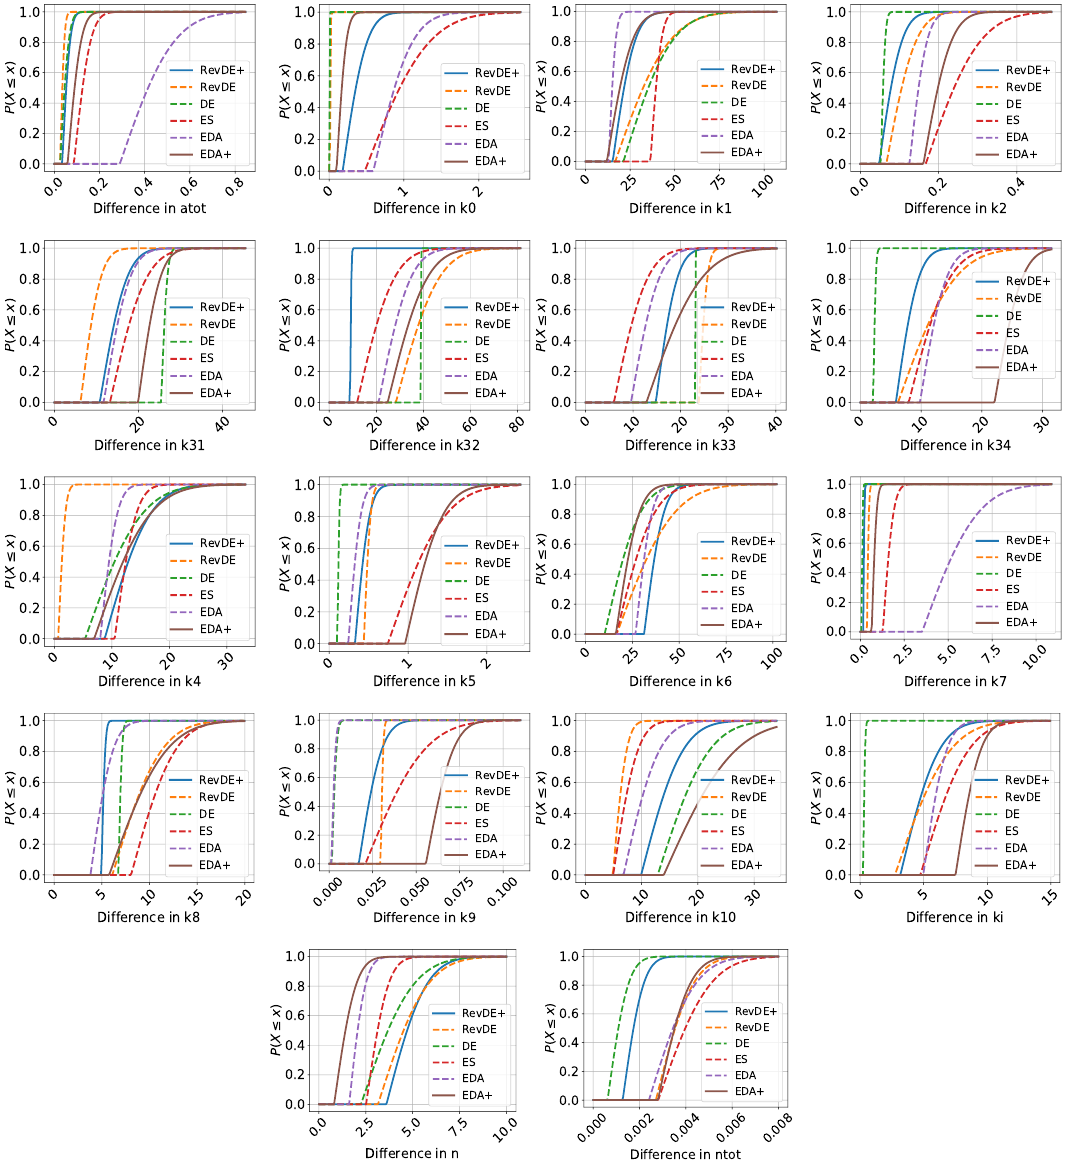
Figure 6. The cumulative distribution functions (cdfs) of the differences for all parameters. Ideally, a cdf of an optimization method should resemble a step-function centered at 0. The averages and the scales are calculated over 3 repetitions of the